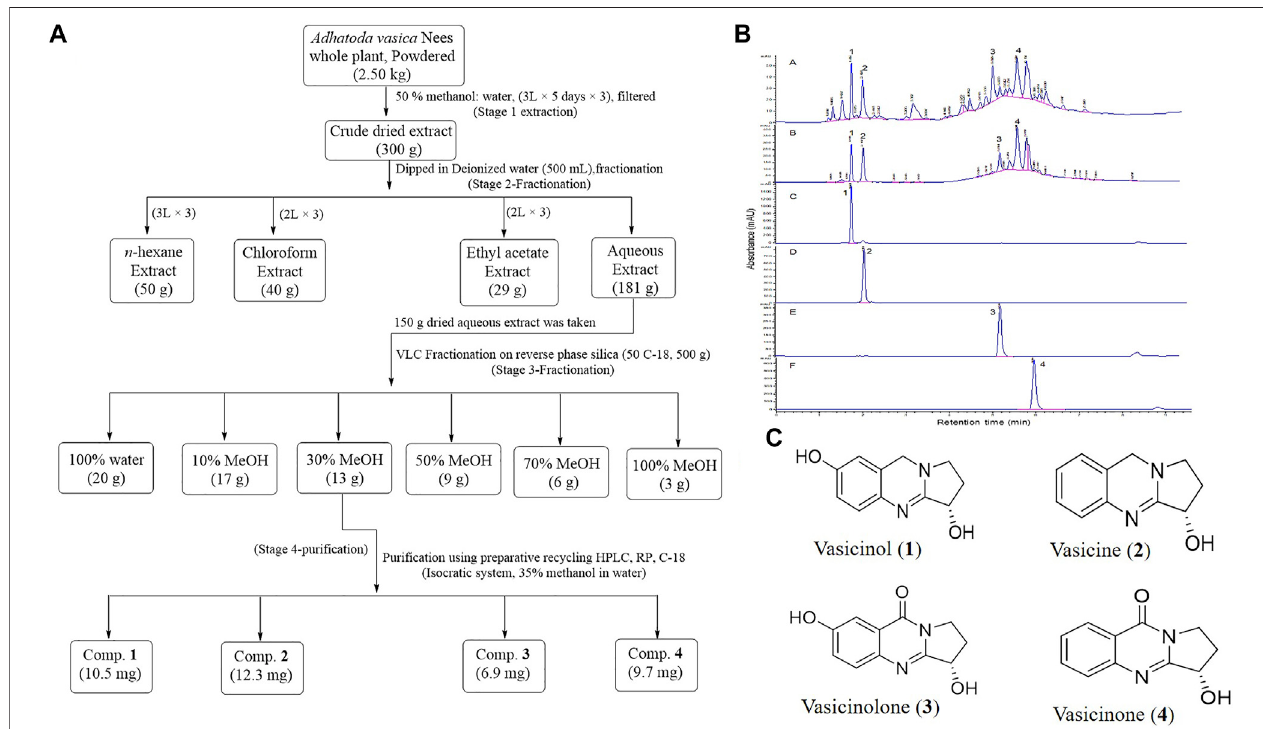
FIGURE3|(A) Schemeforextractionandpuri fi cationofcompounds 1 – 4 . (B) HPLC-DADpro fi lesandannotationofmarkercompounds 1 – 4 incrudeextractsand the most active fraction F3 (A, B), respectively. HPLC-DAD pro fi les of puri fi ed compounds 1 , 2 , 3 , and 4 are C, D, E, and F, respectively. (C) Chemical structures of compounds 1 – 4 puri fi ed from the A. vasica fraction